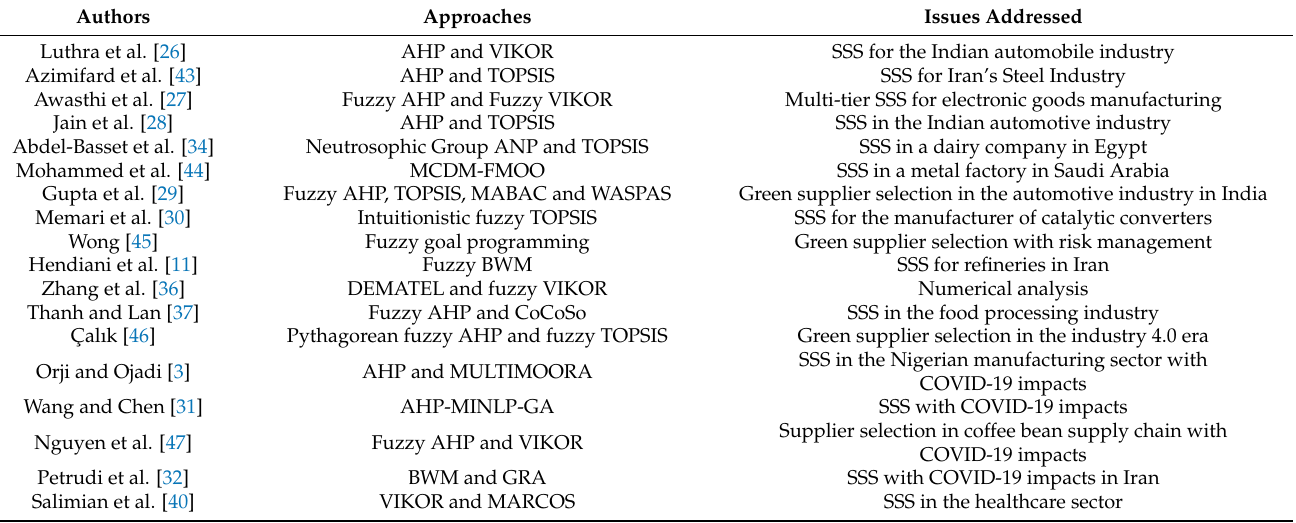
Table 1. Summary of SSS studies’